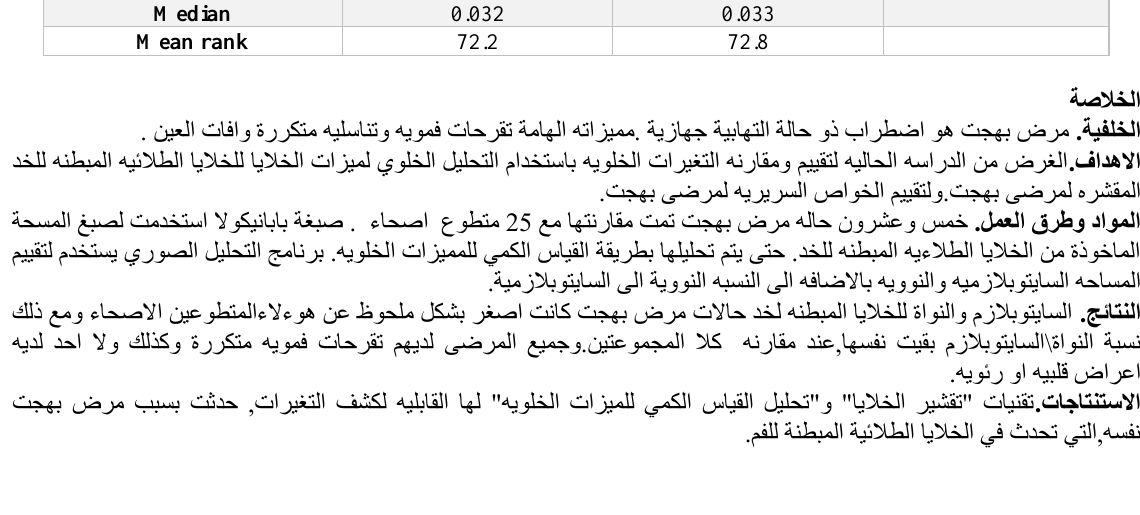
Table 4: Cytomorphometrical analysis of Behçet’s disease case group and Control